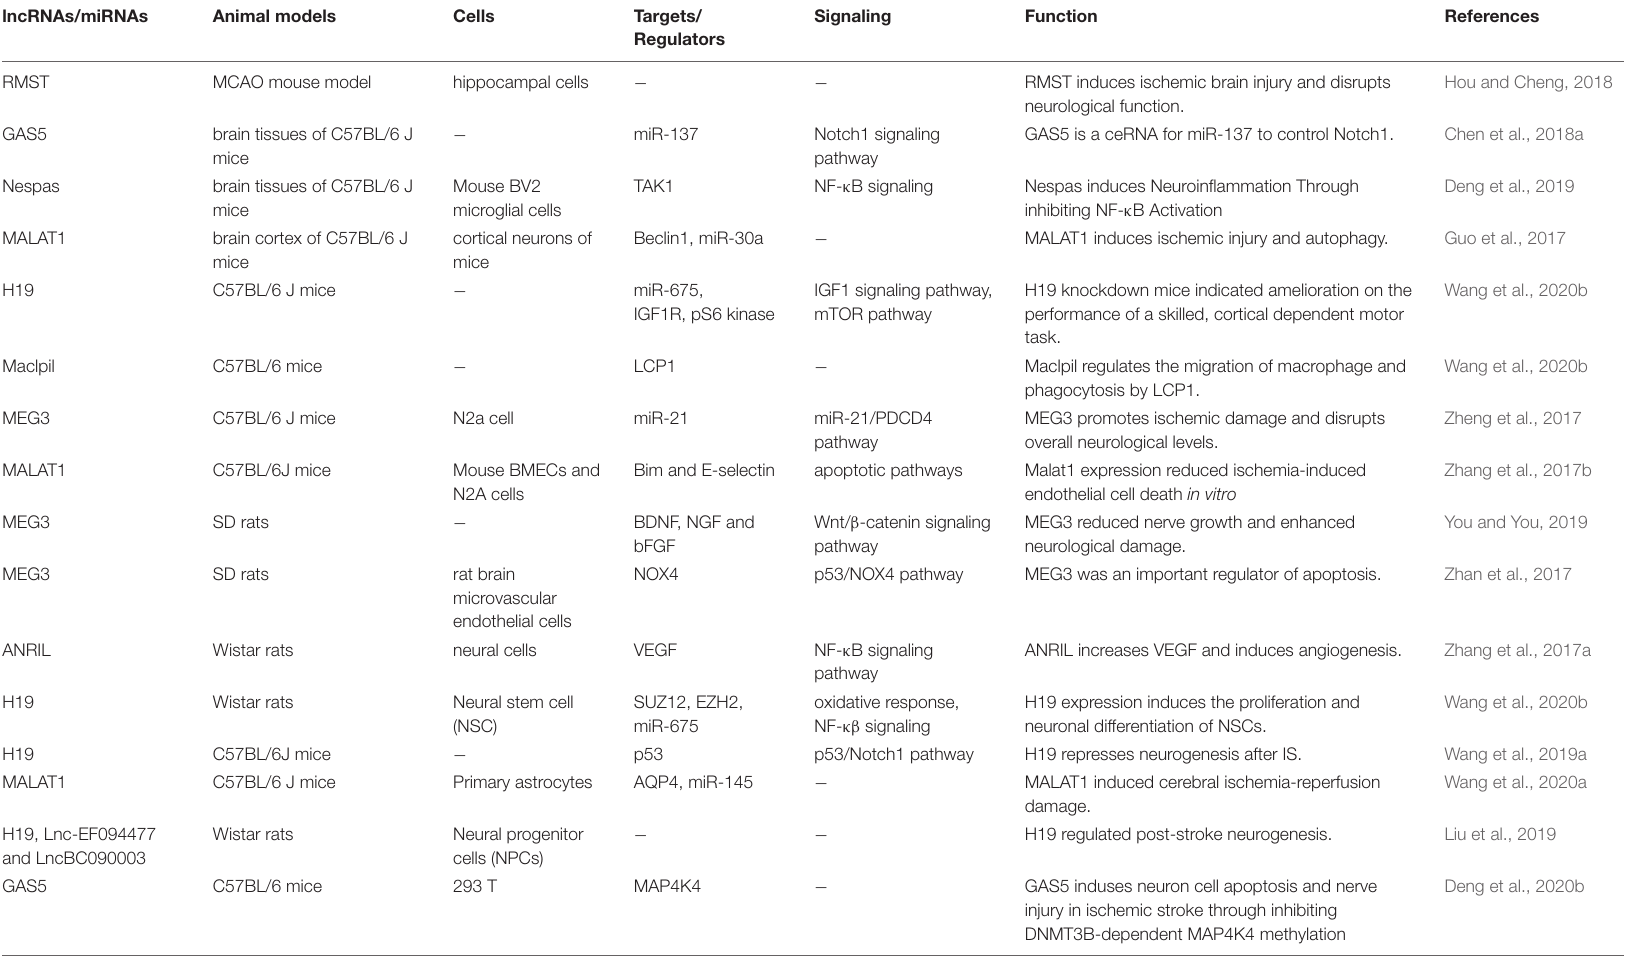
TABLE 7 | Summary of animal studies which displayed elevation of lncRNAs and miRNAs in stroke.